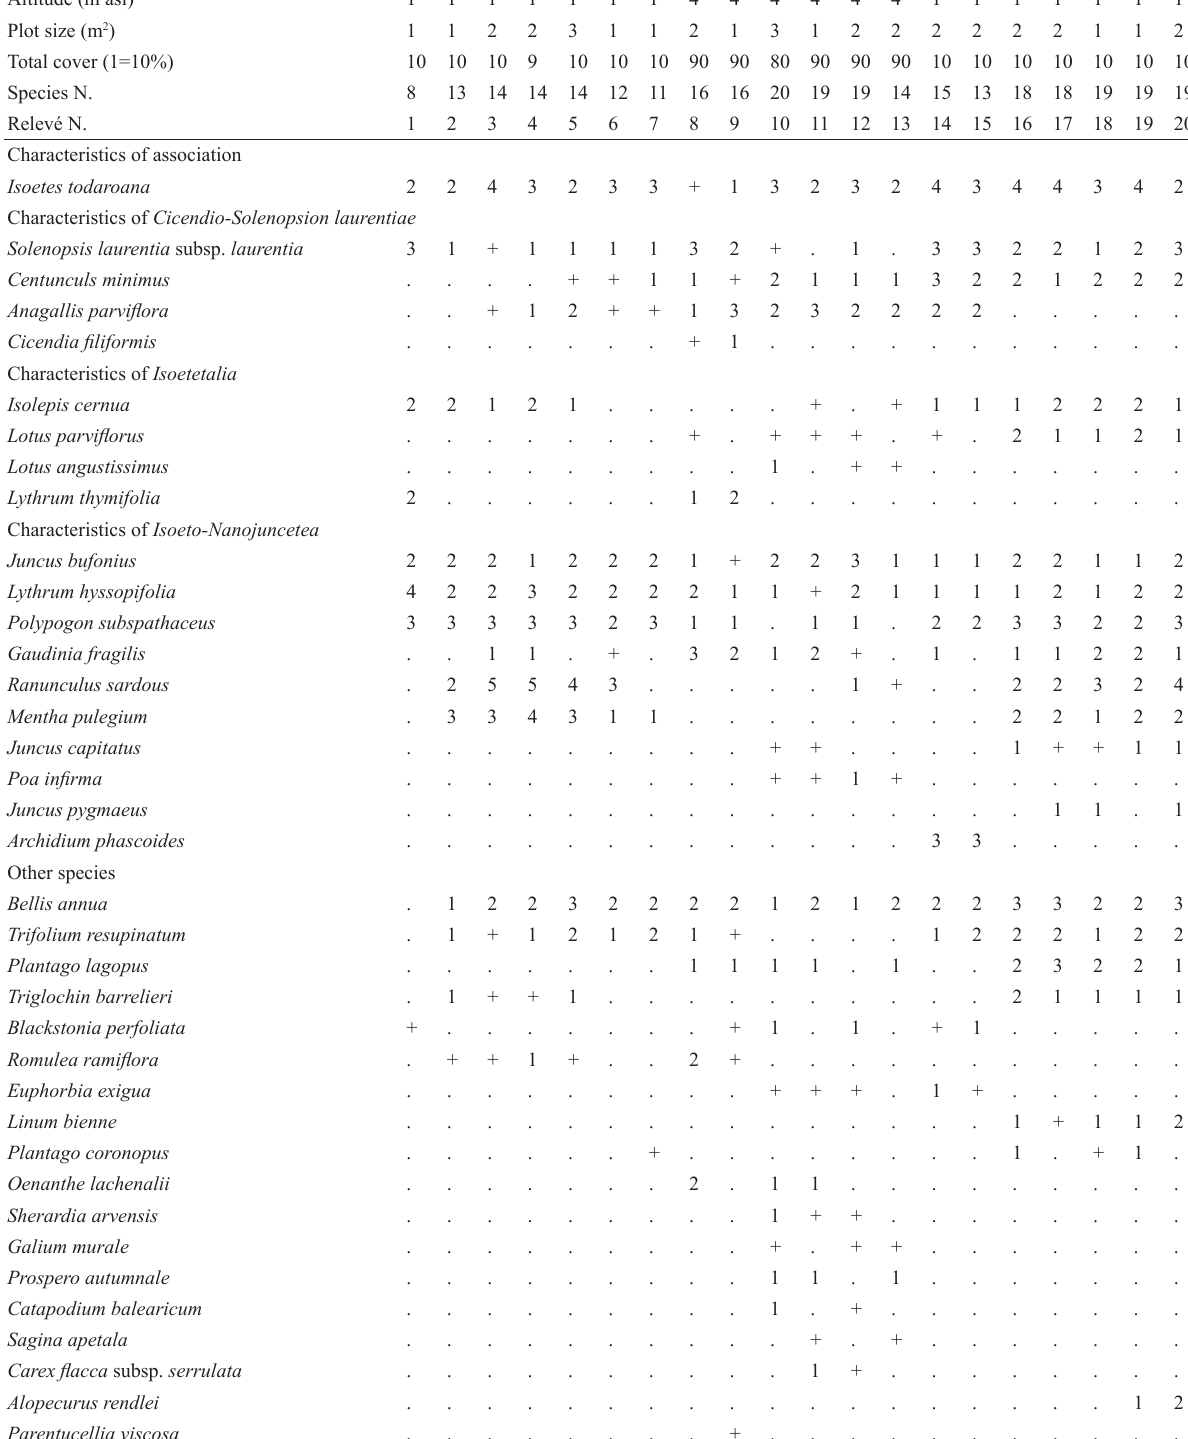
Holotypus : Rel. 12, Table